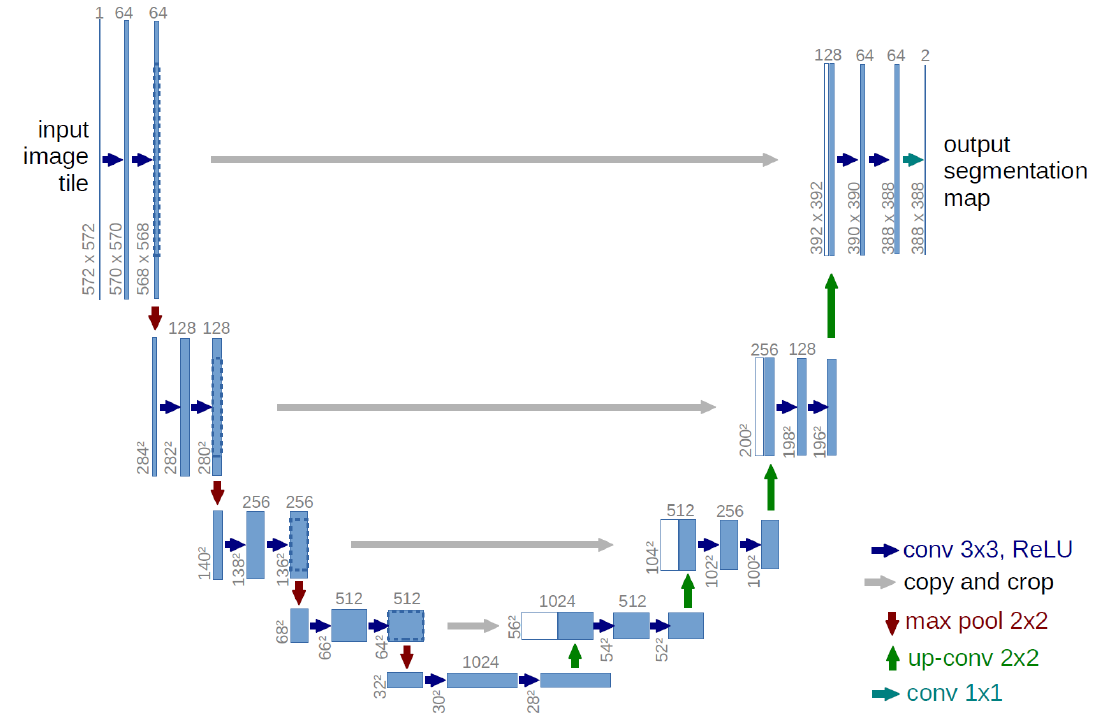
Figure 3: U-Net architecture (Ronneberger et al., 2015). The blue boxes show the feature maps with the number of channels denoted on top. The width and height of the feature maps used in the original paper are shown to the left of each blue box, however this depends on the input image